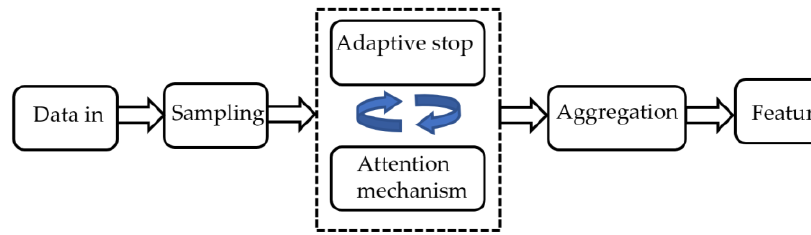
Figure 1. APAT-GCN framework.